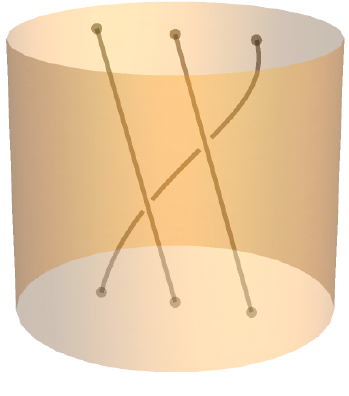
Figure 7. A classical 3-strand braid.